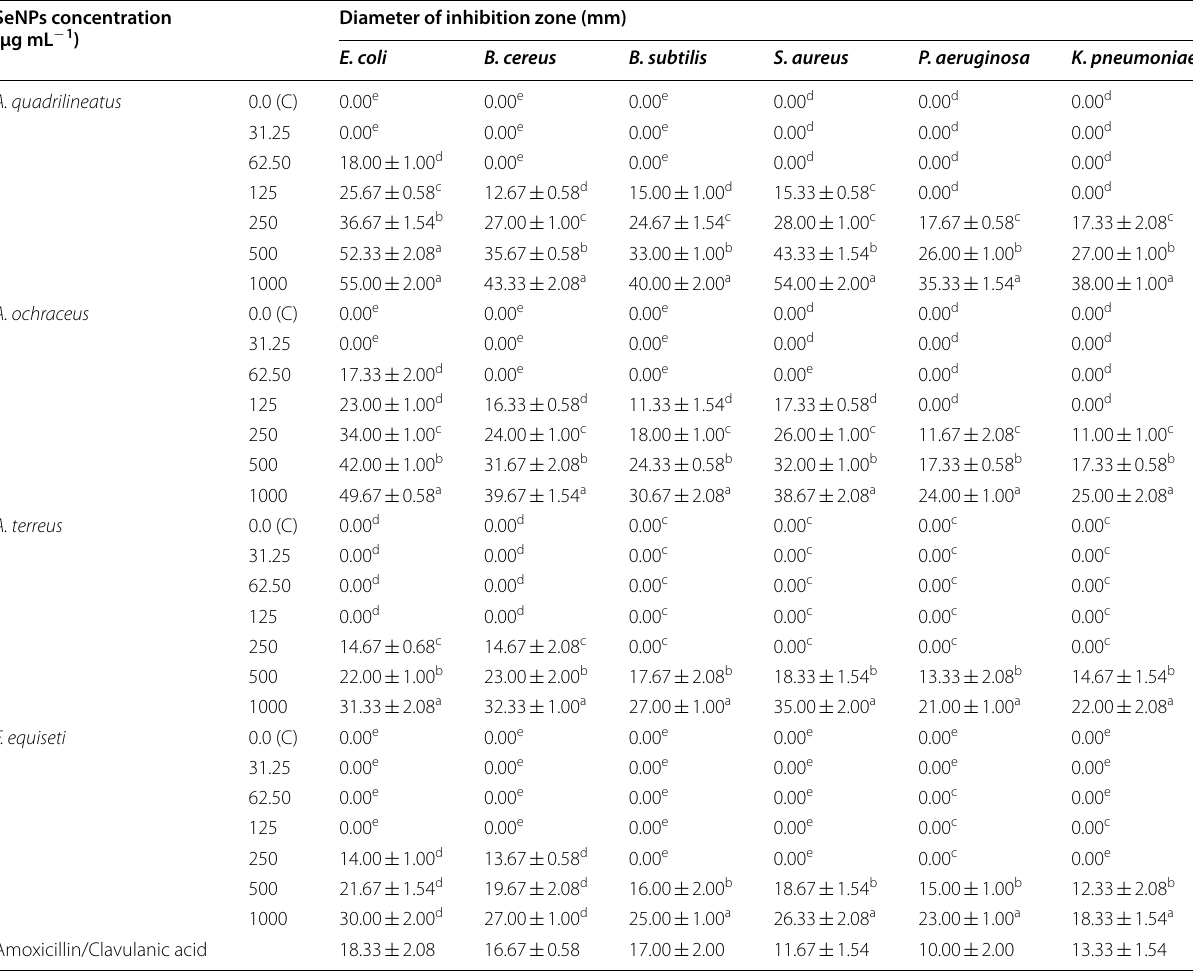
Table 4 Antibacterial activity of SeNPs synthesized by A. quadrilineatus , A. ochraceus , A. terreus , and F. equiseti against different Gram‑ positive and Gram‑negative human pathogenic bacterial